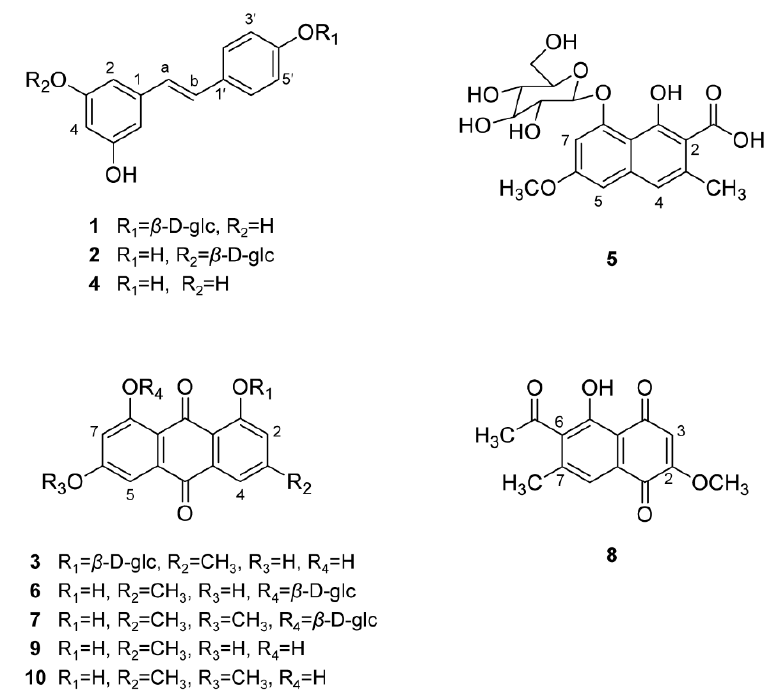
Figure 7. Chemical structures of peaks 1–10. Table 6. Contents of ten compounds ( 1 – 10 ) in the roots of four Reynoutria samples before and after flowering.